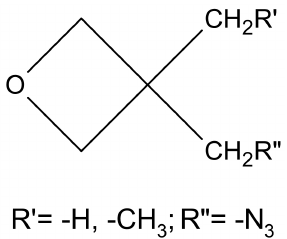
Figure 4. General chemical structure of